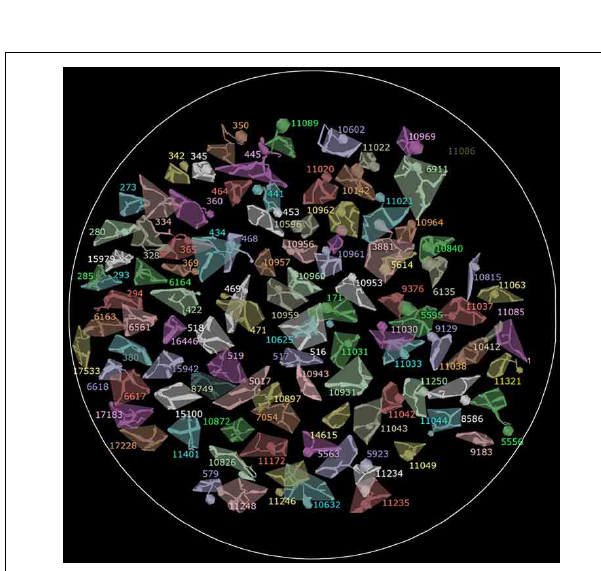
FIGURE 7 | The array of all 104 rod bipolar cell axonal fields in RC1. The shaded polygon represents the convex hull for each cell. In some cases the soma and axon extend at an angle away from the axonal field and are not included in the hull. Circle scale, 0.25mm. FIGURE 8 | AII cell 476—bipolar cell clusters. (A) AII cell 476 (red)